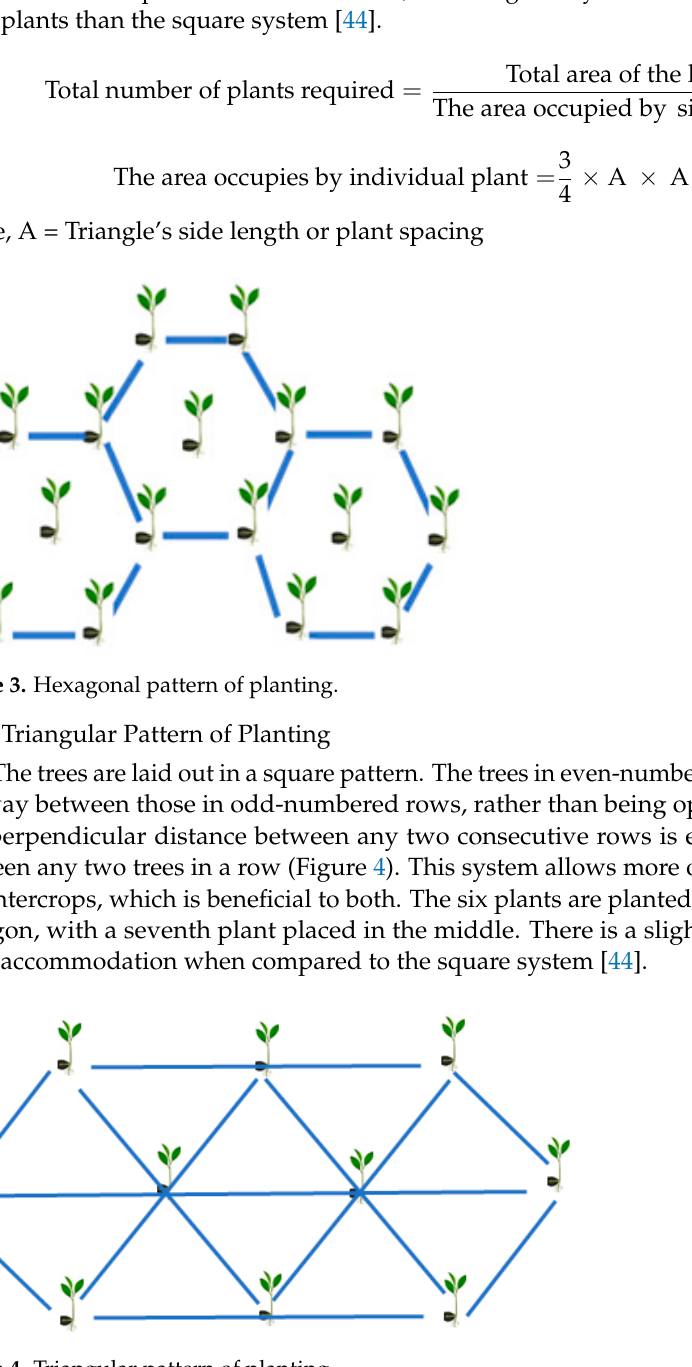
Figure 4. Triangular pattern of planting.